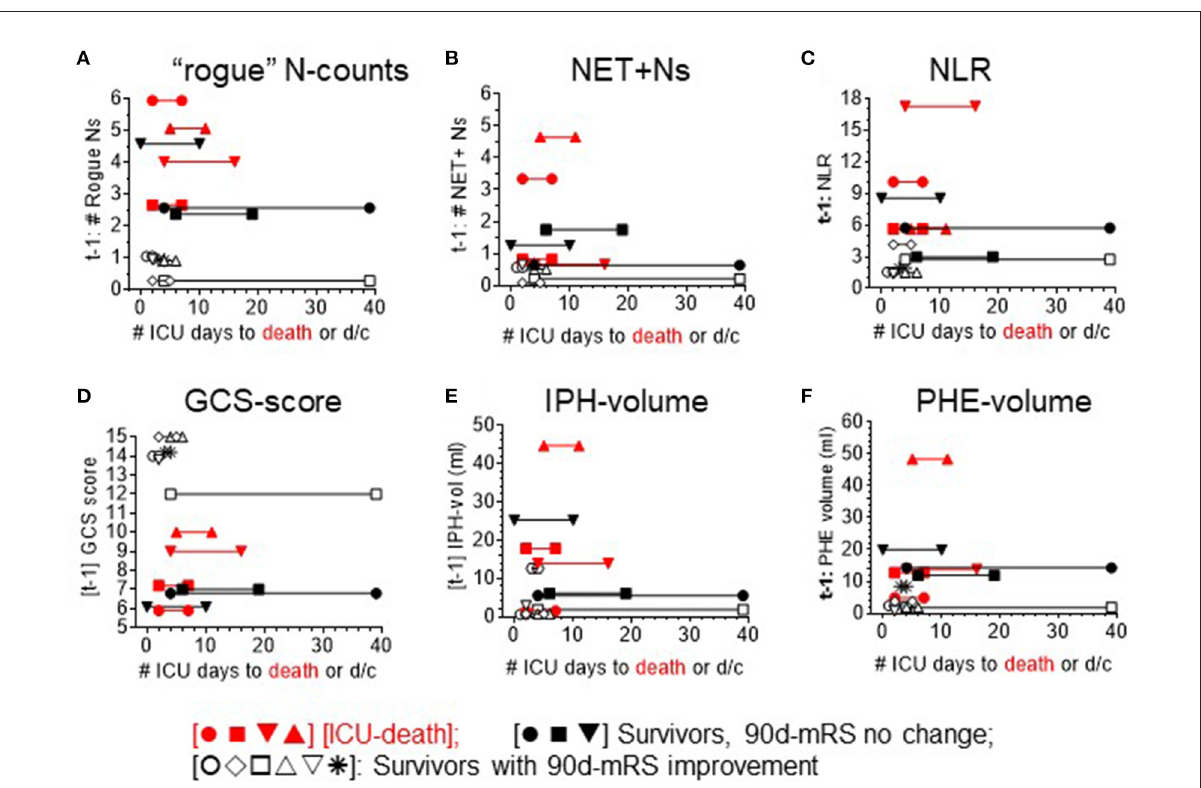
FIGURE4 Mapping of each sICH patient’s ICU course (X-axis) per level of different analysis parameters. ICU course: timeline to discharge (d/c) or death plotted against level of neutrophil measures: (A) DEspR + CD11b + neutrophil counts (“rogue” N counts, K/ µ l). (B) intravascular NET + neutrophils (NET + N counts, K/ µ l). (C) neutrophil-to-lymphocyte ratio (NLR), clinical measure of neurological deficits: (D) Glasgow Coma Scale-score (GCS), as well as radiological measures of sICH severity: (E) intraparenchymal hemorrhage (IPH)-volume, and (F) perihematomal